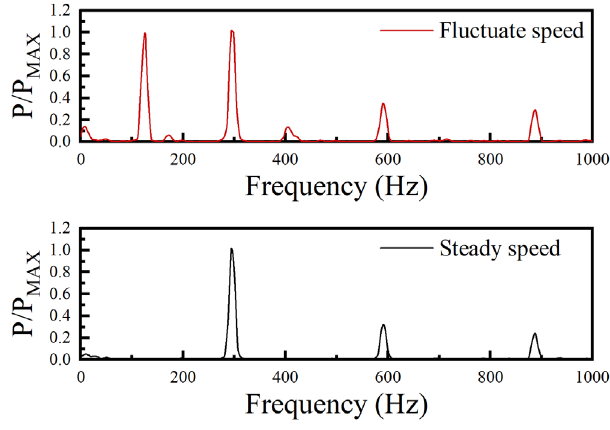
Fig. 19. Calculation results of pressure fl uctuation in water pump outlet fl ow